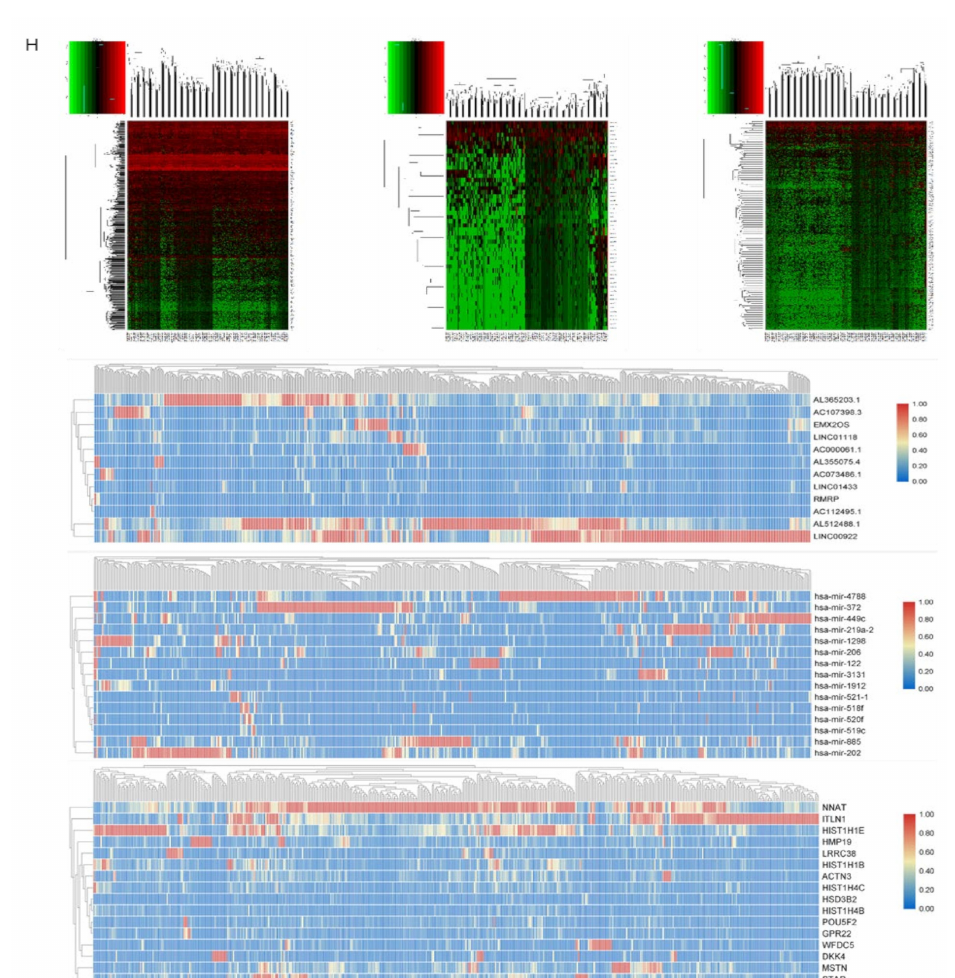
Figure 2. Distributions of expressed genes in LUAD (log2FC > 0.5 and adjusted p -value < 0.05). The volcano plot of 1292 differentially expressed long noncoding RNAs (DElncRNAs) ( A ), 147 differentially expressed microRNAs (DEmiR- NAs) ( B ), and 1640 differentially expressed mRNAs (DEmRNAs) ( C ). Red stands for upregulation, and green stands for downregulation. The x-axis depicts the value of log2FC, and the y-axis depicts the value of log10 ( p -value). In the competitive endogenous RNA (ceRNA) network constructed by differentially expressed genes related to MYC, green and blue represent downregulated genes, while red represents upregulated genes ( D ). The expression levels of WT1-AS, miR-206 and nicotinamide phosphoribosyltransferase (NAMPT) were significantly correlated with patient survival ( E – G ). Heat maps of differential genes ( H